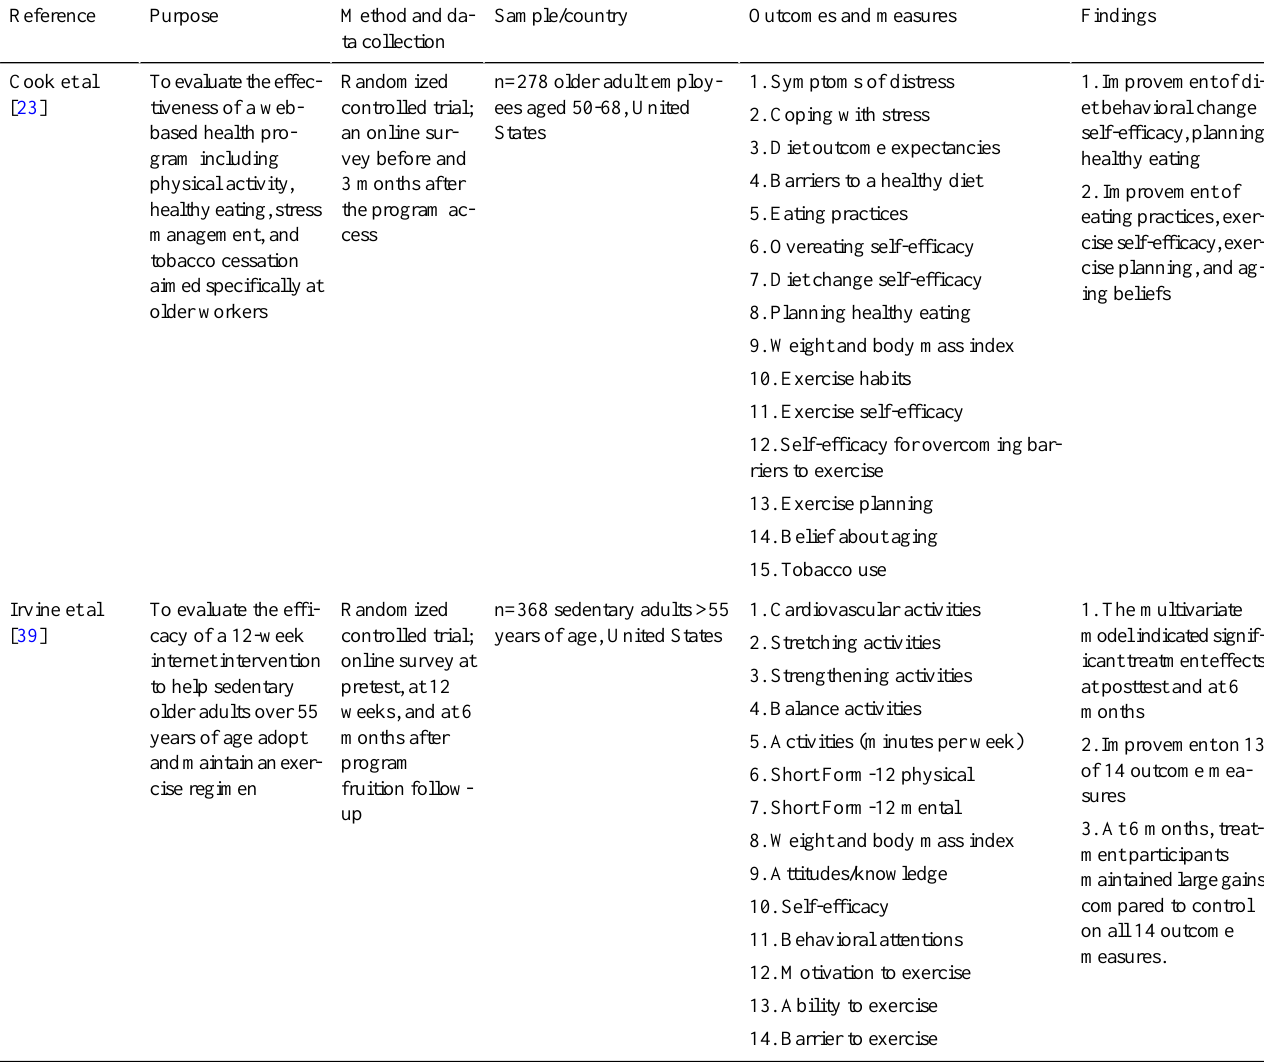
Table 1. Specifications and main findings of the studies included in the systematic literature review.